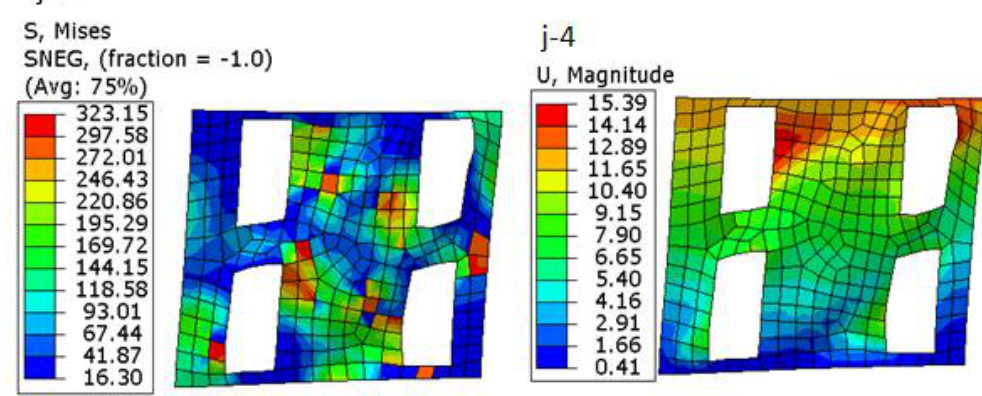
Figure 30. Von Mises stress for shell part (j-1) frame part and (j-2) steel plate.